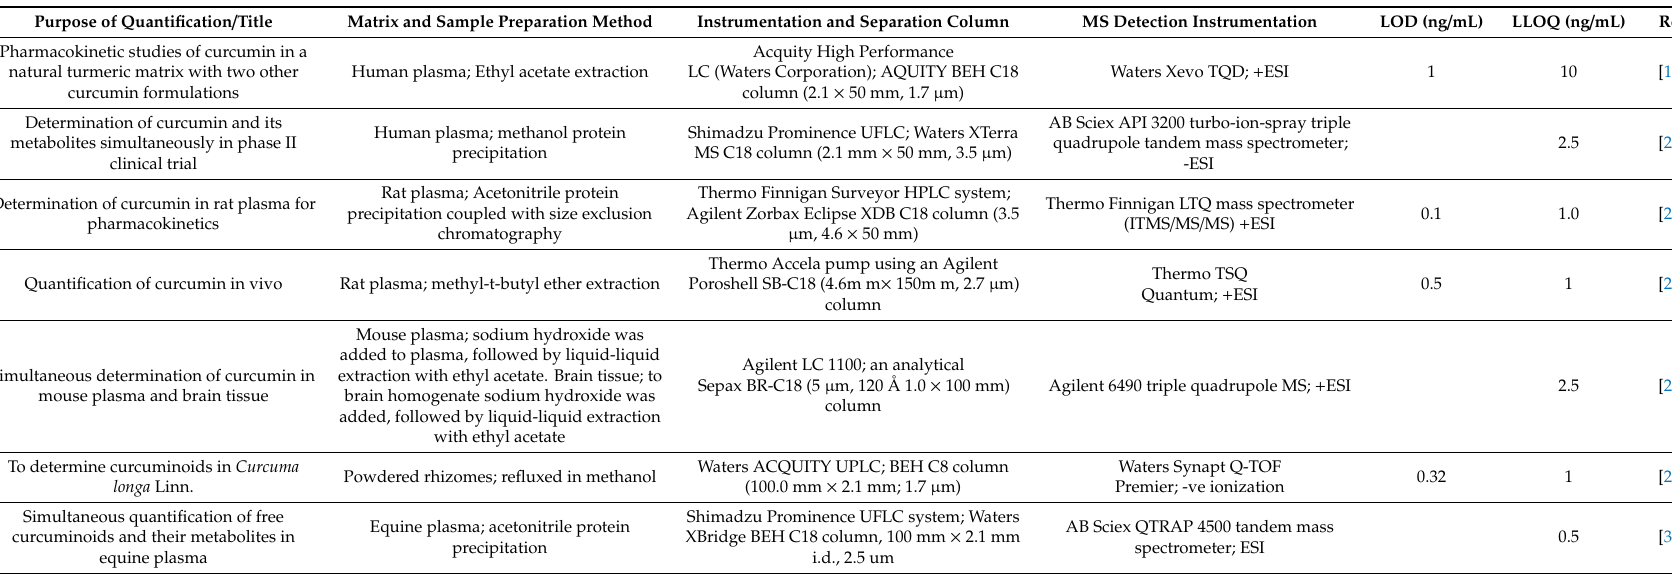
Table 4. A brief summary of recent literature on the LC-MS analytical methods used for the assay of turmeric